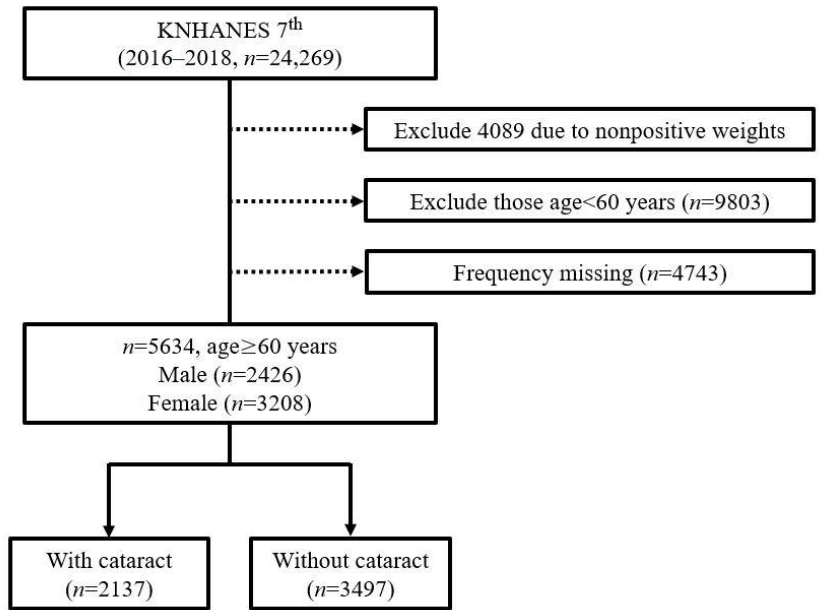
Figure 1. Flow chart for the selection of study participants.